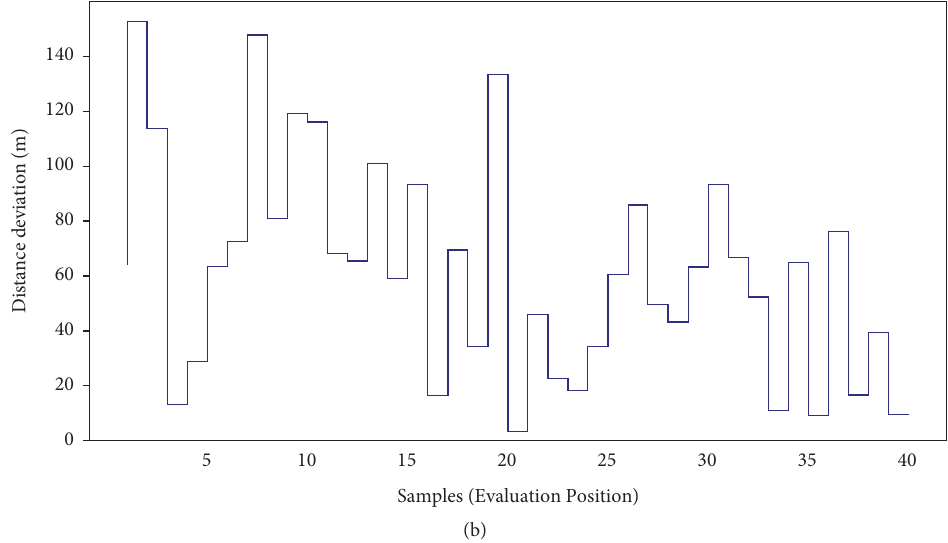
Figure 14: Performance of proposed model for normal sea-ice scene. (a) Recommended and actual courses for normal sea-ice scene. (b) Distance error distribution for simple sea-ice